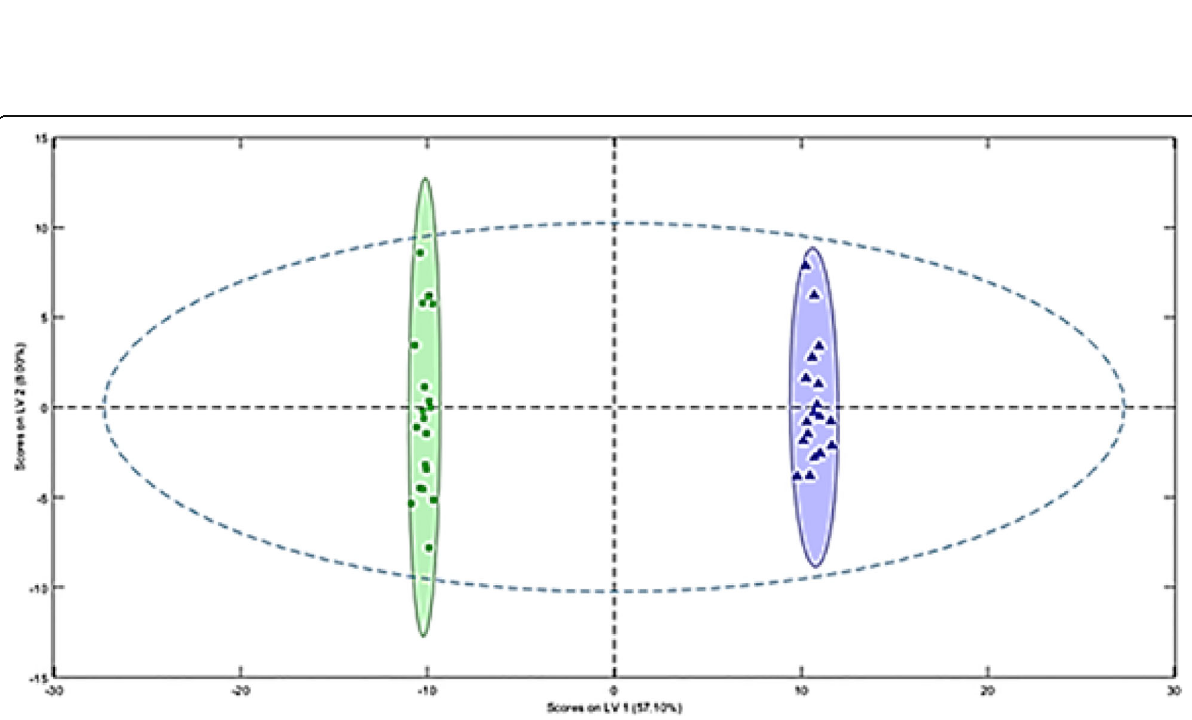
Fig. 3 OPLS leverage plot for STEMI (green) vs NSTEMI patients